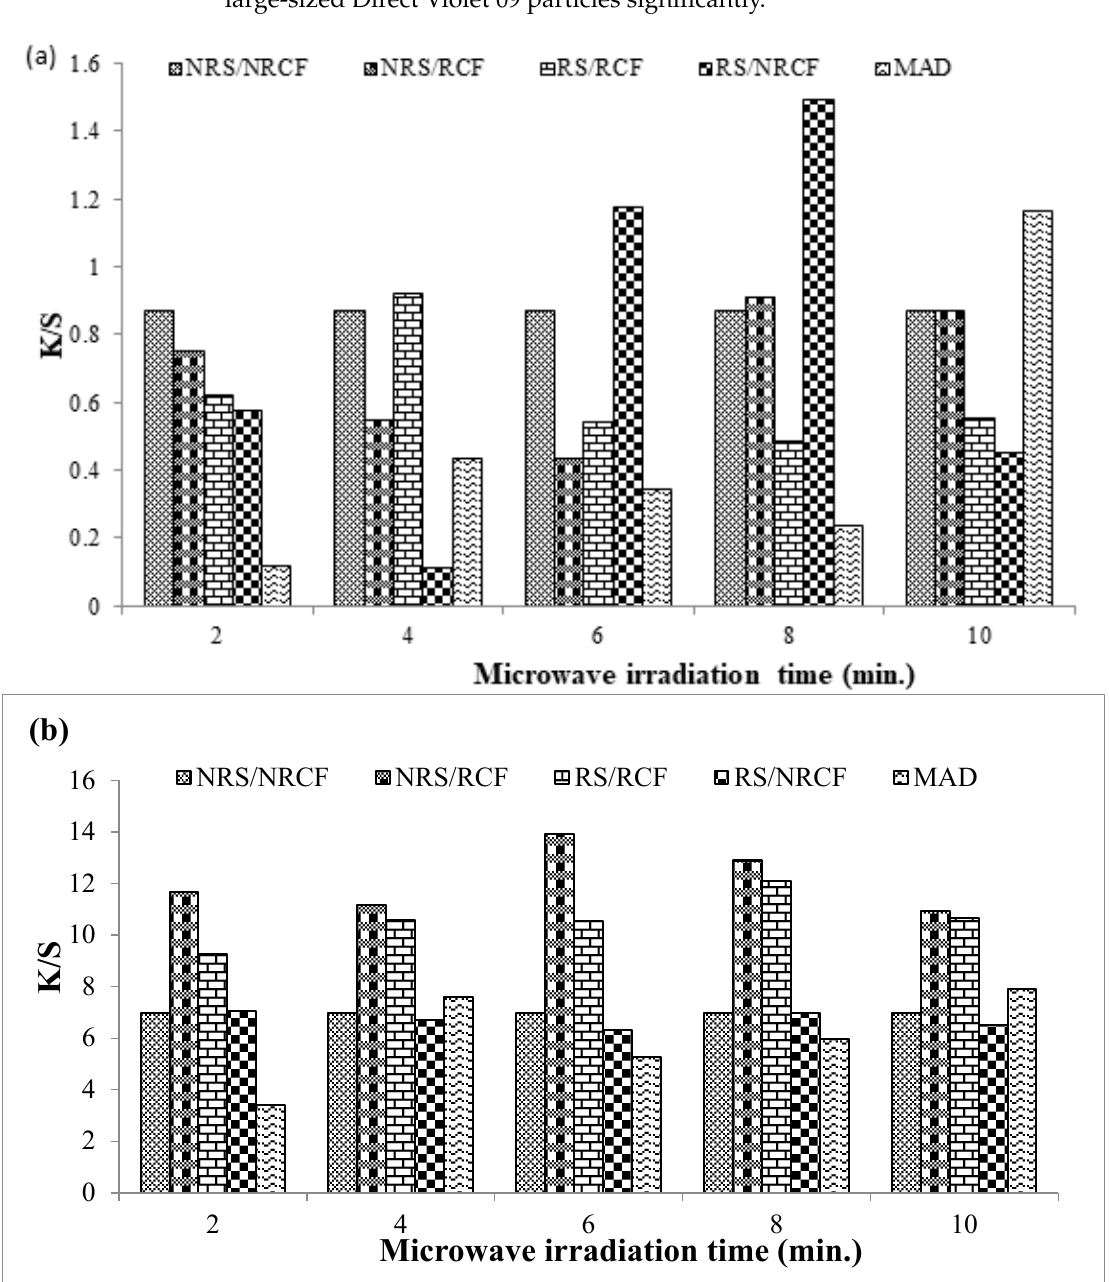
Figure 2. Dyeing of microwave-treated and un-treated cotton fabric with Reactive Violet 05 ( a ) and Direct Violet 09 ( b ) dye.